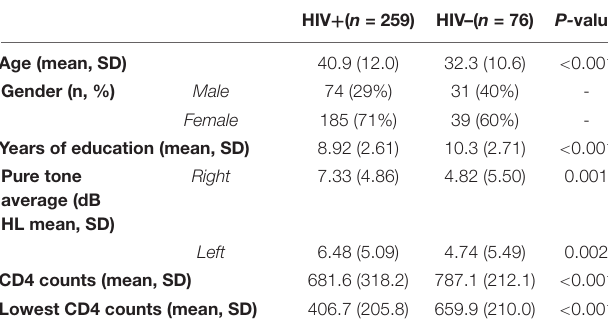
TABLE 1 | Summary of study demographics between HIV